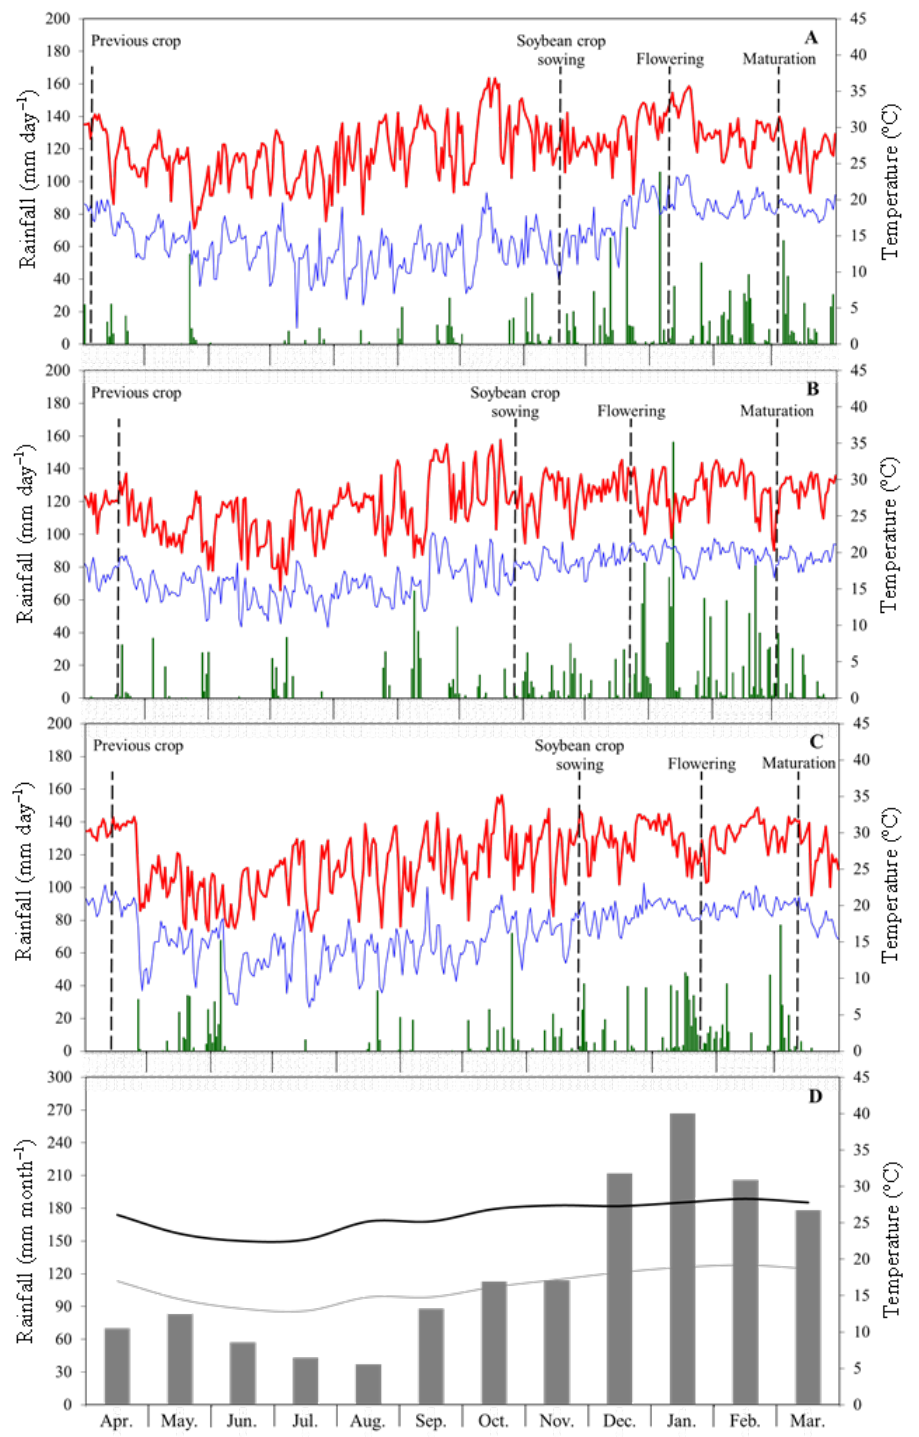
Figure 1. Daily rainfall (green bar) and maximum (red line) and minimum (blue line) temperatures in the experimental area at Botucatu, S ã o Paulo State, Brazil, during the period from April to March in the 2014–2015 ( A ), 2015–2016 ( B ), and 2016–2017 ( C ) periods, as well as 50-year averaged monthly rainfall (grey bar) and maximum (black line) and minimum (grey line) temperatures ( D ). Dashed lines indicate dates of sowing of the previous crops and sowing, flowering, and maturation of soybean crop in each growing season.